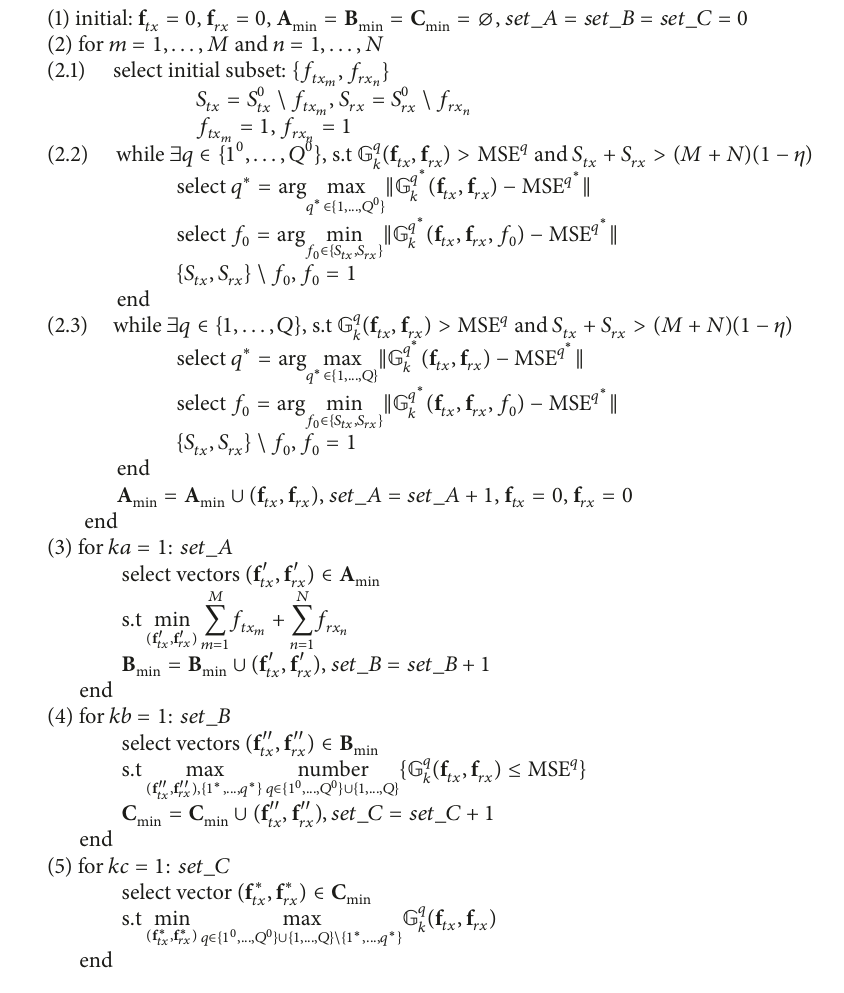
Algorithm 2: MFMLS_OAT subset selection